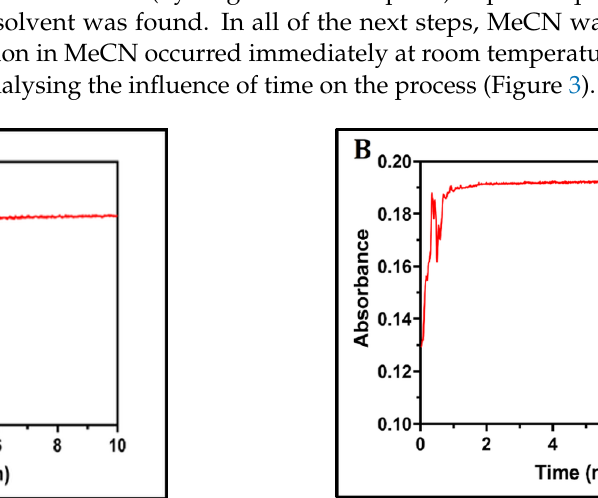
Figure 3. The absorbance of the reaction mixture of LGN (1 × 10 – 4 M) with DDQ (1 × 10 – 4 M), meas- ured at 487 nm ( A ), and with CHA (1 × 10 – 4 M) measured at 514 nm ( B ), and plotted against the measured at 487 nm ( A ), and with CHA (1 × 10 –4 M) measured at 514 nm ( B ), and plotted against corresponding reaction time. the corresponding reaction time.